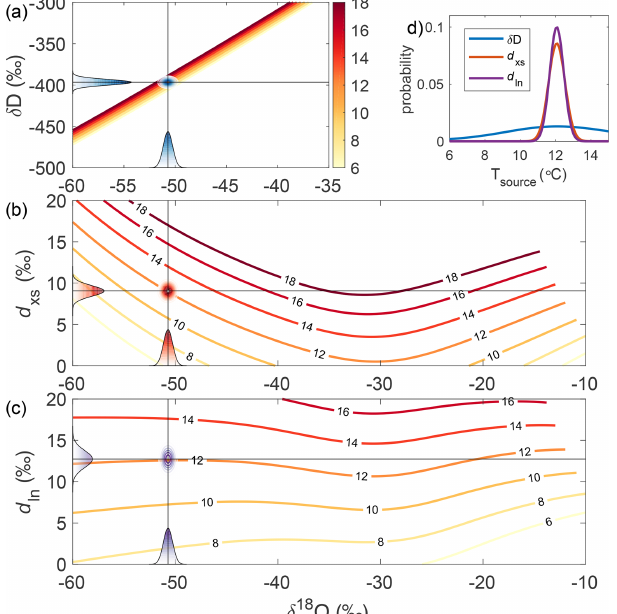
Figure A15. (a) Evaporation source temperature, T 0 , contours as a function of modeled δ 18 O and δ D of precipitation. Uncertainty in δ 18 O and δ D for an interval or sample is shown as PDFs of un- certainty along the respective axes. The intersection of these PDFs on the T 0 surface results in a two-dimensional PDF in the recon- structed value of T 0 , shown as a target. (b, c) Same as panel (a) but for the evaporation source temperature projected onto the δ 18 O and d xs axes and the δ 18 O and d ln axes, respectively. Uncertainties in δ 18 O and δ D in panel (a) are propagated into the PDF on the d xs and d ln axes in (b, c) . (d) The uncertainty in the reconstructed evap- oration source temperature ( T source = T 0 ) owing to the weighting of the combined two-dimensional PDFs from panels (a) (in blue), (b) (in red), and (c) (in purple).